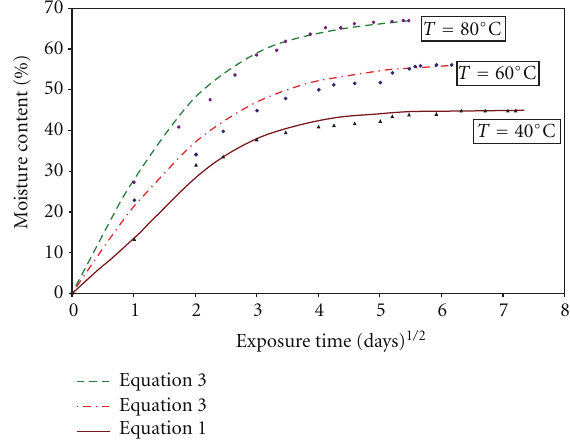
Figure 4: Average moisture absorption in di ff erent aging condition (humidity = 60%). (solid lines represent the best fit lines obtained by the noted respective